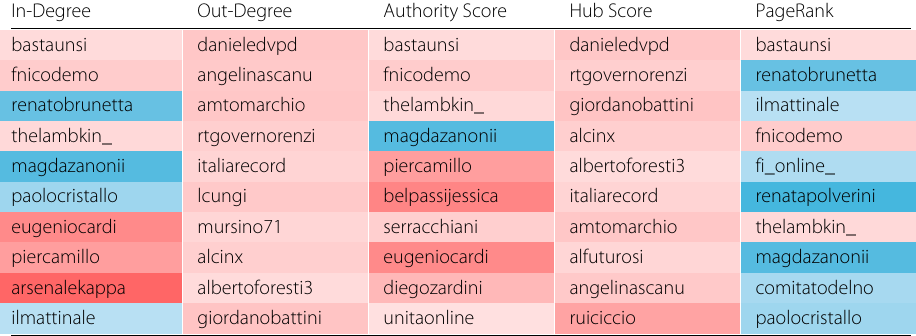
Table 5 PI4 retweet graph: top 10 accounts by centrality In-Degree Out-Degree Authority Score Hub Score